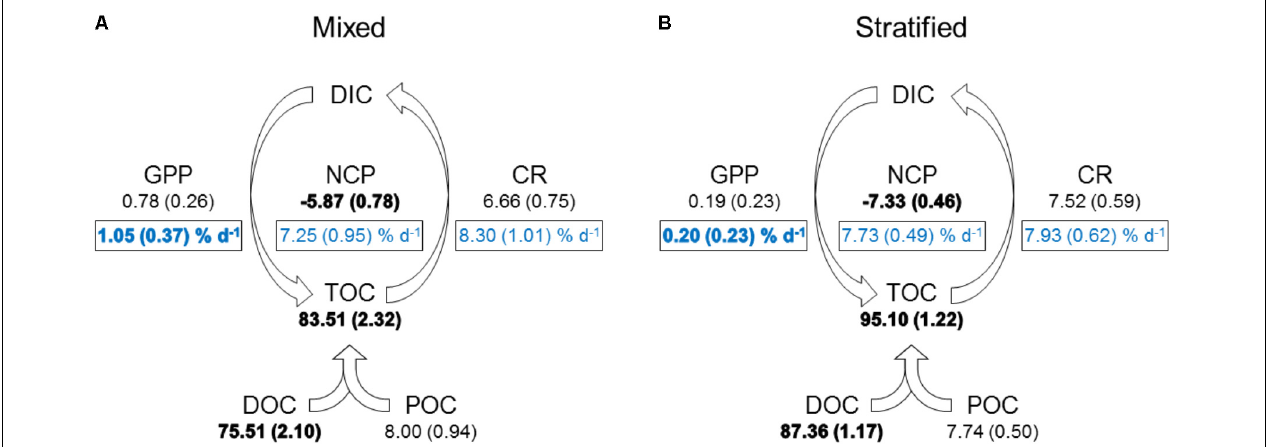
FIGURE 3 | Mean daily planktonic carbon balance in mixed (A) and stratified (B) periods. GPP, gross primary production; CR, community respiration; NCP, net community production (GPP–CR). Values given as mean (SE). GPP, CR, NCP in µ mol C L − 1 d − 1 . DOC, dissolved organic carbon; TOC, total organic carbon [POC (particulate organic carbon) + DOC], TOC, DOC, and POC in µ mol C L − 1 ; DIC, dissolved inorganic carbon. Boxed light blue text constitutes the percentage of planktonic C contributed daily to TOC [mean (SE)]. Bold indicates a significant difference between periods ( p < 0.05).